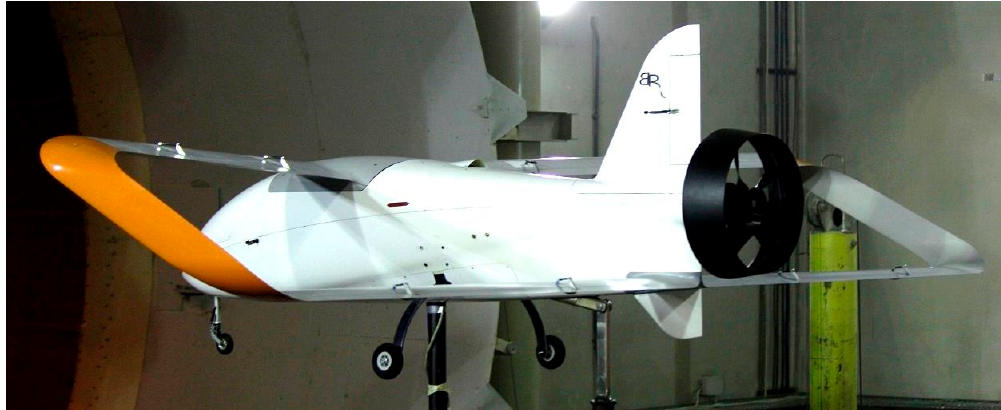
Figure 21. The airplane with ducted fan propulsion (photo took by Krzysztof Bogda ń ski).